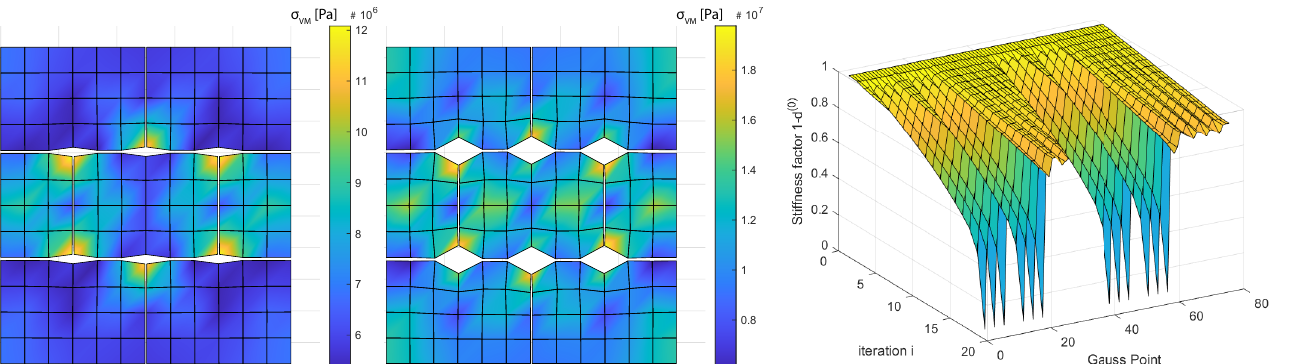
Figure 7. Failure according to von Misses energy criterion. From left to right : region 1 a before failure, one step after failure and stress reduction after damage law expansion. Micro-scale deformation magnification 10 × . G = 10 14 Pa. Failure Region 1a has a ratio (cid:101) yy / (cid:101) xx = 3.1, which makes it natural to be the